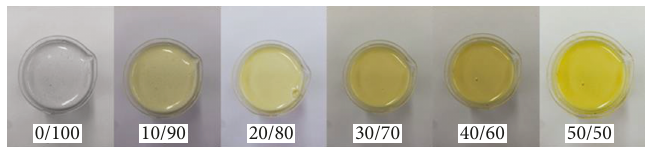
Figure 10: The state of HEC emulsion solution after hot rolling at 100 ° C after 16